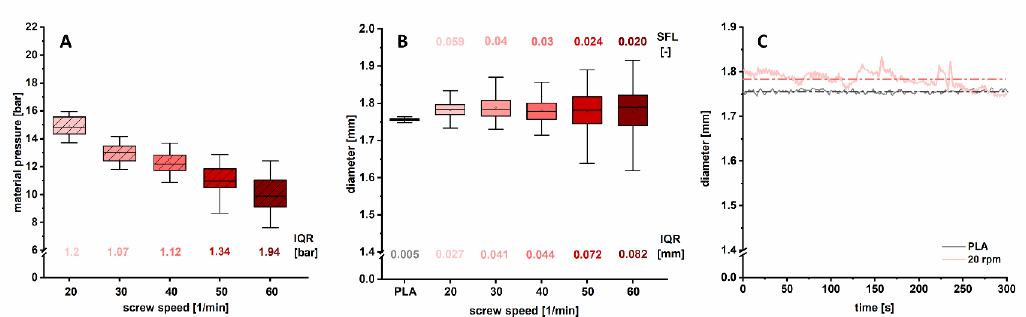
Figure 6. Boxplot of material pressure ( A ) and filament diameter ( B ) for different applied screw speeds during extrusion (1 Hz; n > 290). Resulting SFL and IQRs (box width) are indicated. Inline determined diameter as function of time for commercial PLA filament compared to produced filament with 20 rpm ( C ); dashed lines mark the mean value.